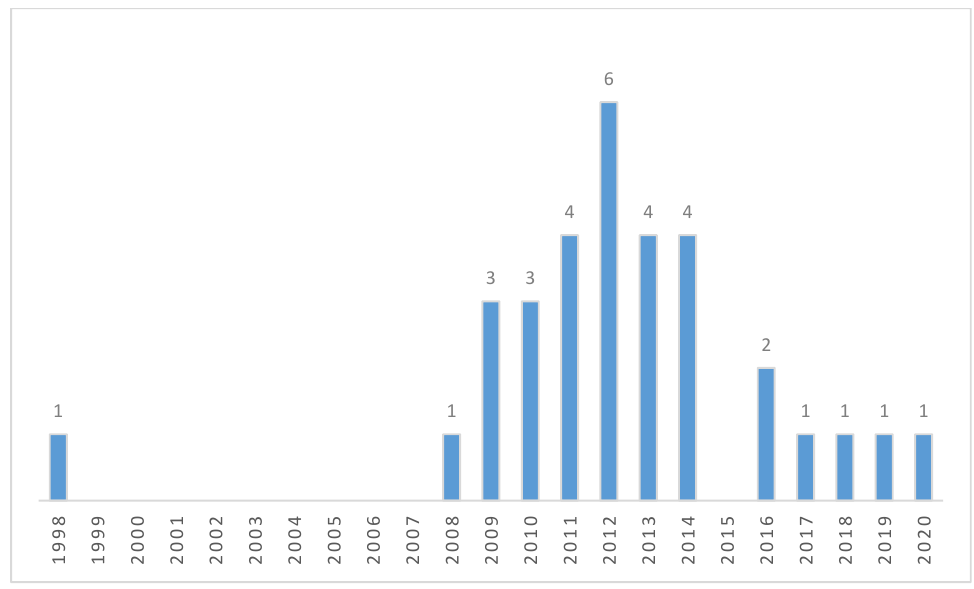
Figure 3. Publications on Carabidae in energy willow and poplar plantations—number per year. Articles found in three scientific databases: International Web of Science, Scopus and CEON Biblioteka Nauki after discarding unrelated works and duplicated records.